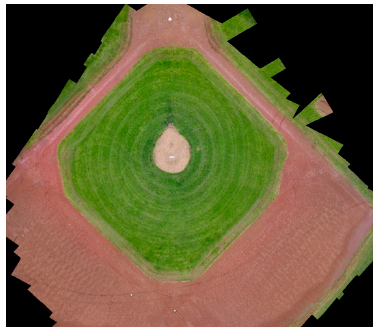
Figure 6. Reconstructed orthophoto from multiple photographs.